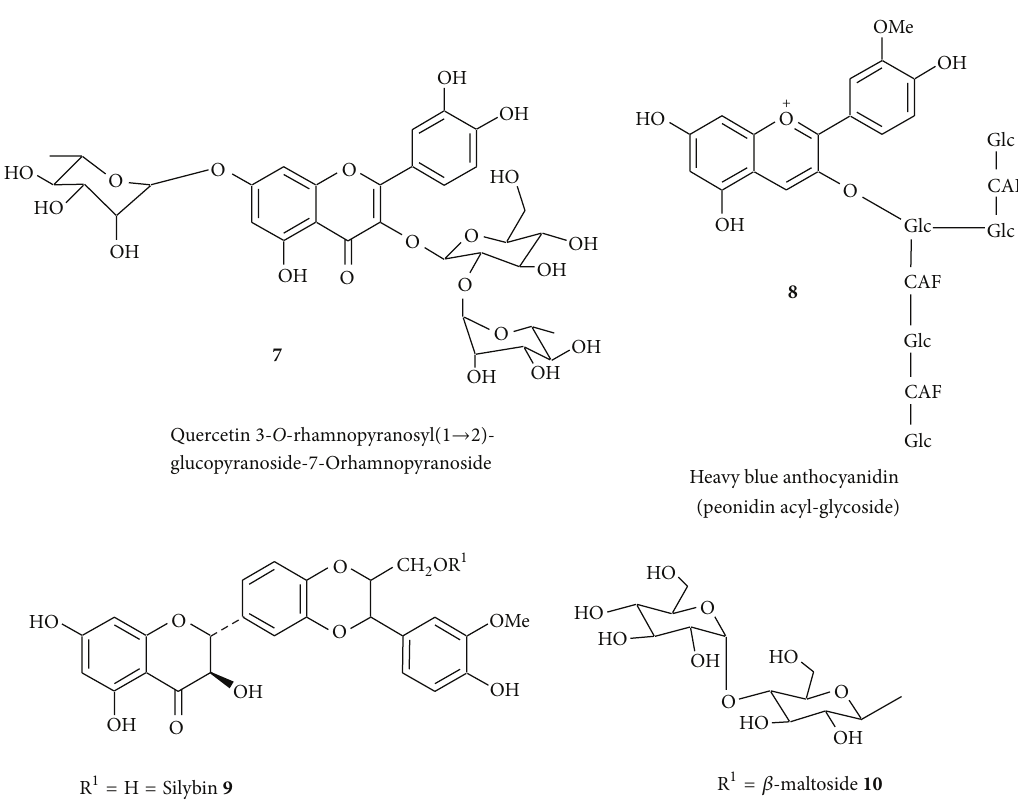
Figure 1: Base structure and subgroups of flavonoids.